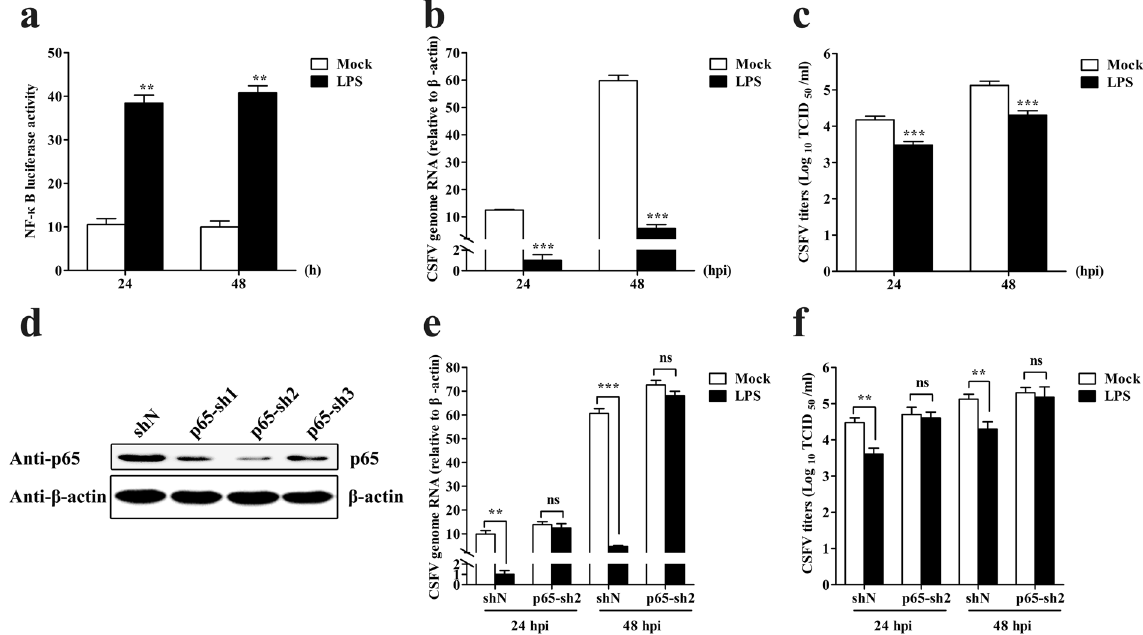
Figure 5. LPS inhibits CSFV replication in PAMs via the NF- κ B-signalling pathway. ( a ) LPS treatment increases NF- κ B activity in PAMs. PAMs were treated with LPS, and cell lysates were subjected to dual- luciferase reporter assays to determine NF- κ B luciferase activity at 24 h and 48 h. ( b , c ) LPS treatment decreases CSFV replication in PAMs. RT-PCR analysed CSFV genome RNA, and viral titres in the supernatant were assessed and expressed as TCID 50 /ml in LPS-treated PAMs at 24 and 48 hpi. ( d ) p65 knockdown by shRNA in PAMs. PAMs were transfected with p65-sh1, p65-sh2, p65-sh3 or shN and the cell lysates were subjected to determination of endogenous p65 expression by Western blot at 48 hpt. ( e , f ) LPS does not inhibit CSFV replication in p65-knockdown PAMs. PAMs treated with LPS were transfected with p65-sh2 and infected with CSFV. CSFV genome RNA and viral titres were determined at 24 and 48 hpi. The data represent the mean ± SD of three independent experiments. ** P < 0.01 and *** P < 0.001 calculated using Student’s t-test . ns: not